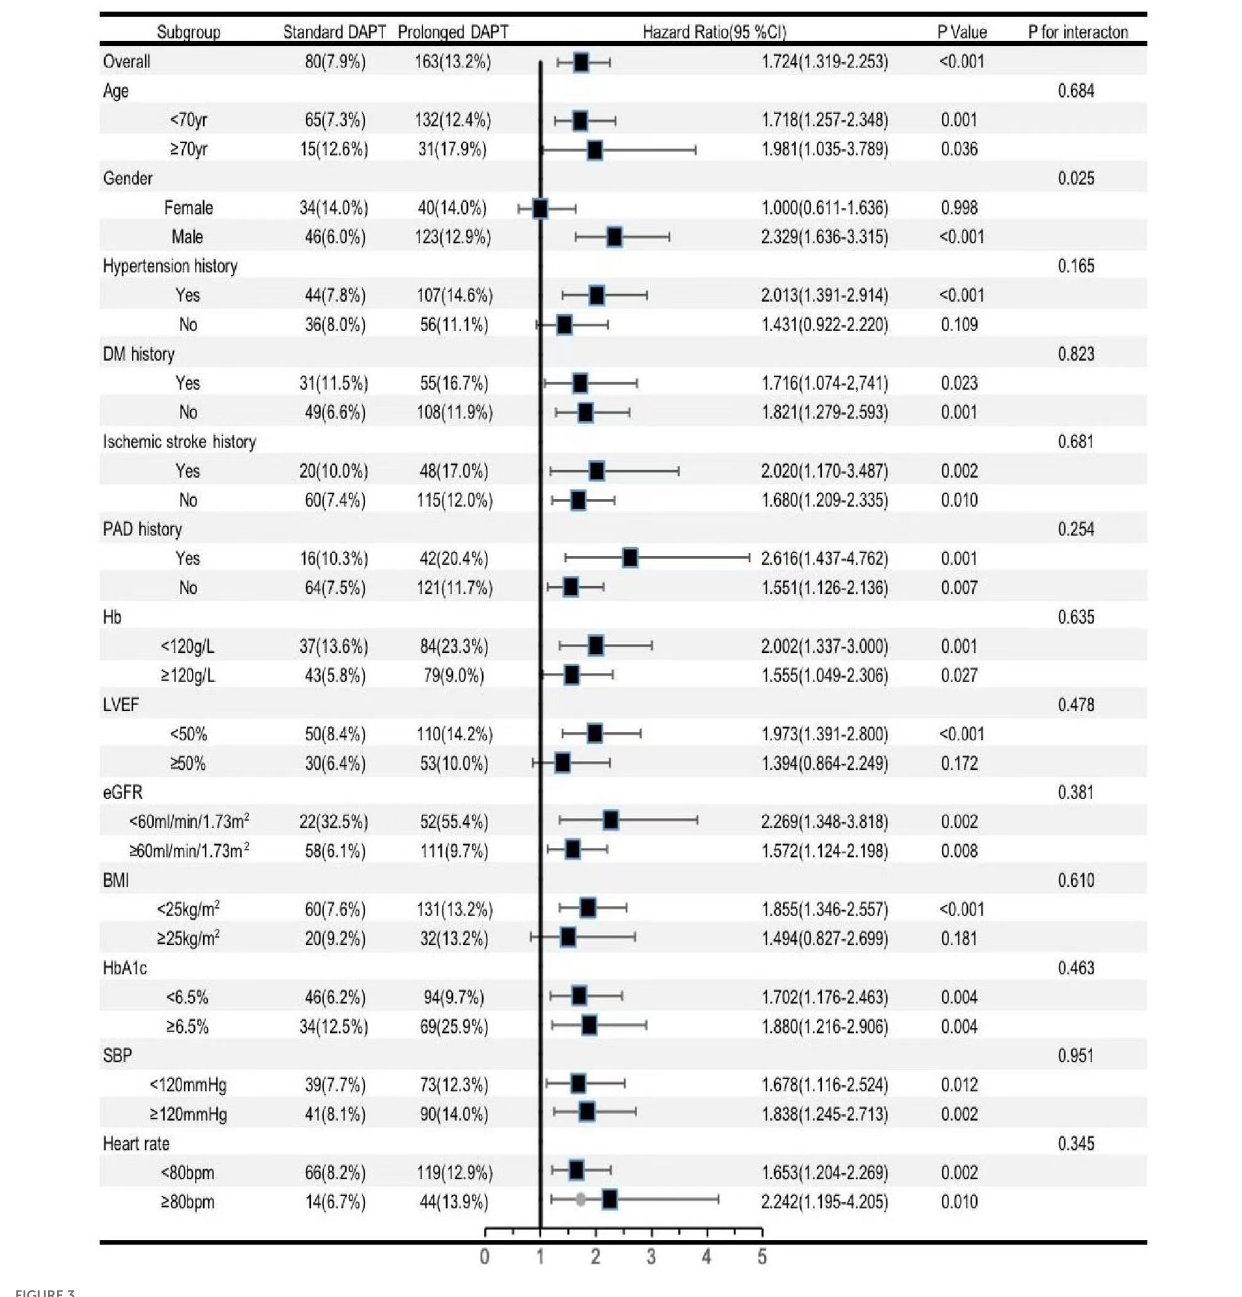
of UA. Therefore, enhanced antiplatelet therapy is important for bleeding events in East Asians as opposed to clopidogrel, according to